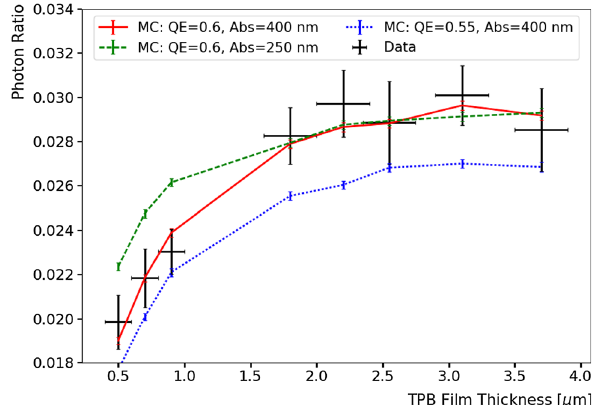
Fig. 12 Themeasured, β i , exp ,andsimulated, β i , sim ,photonratiosplot- tedasafunctionofsamplethicknessfordataandMonteCarloforseveral choices of VUV QE and VUV absorption length for 130-nm incident light. The SQE is held fixed at 0.9